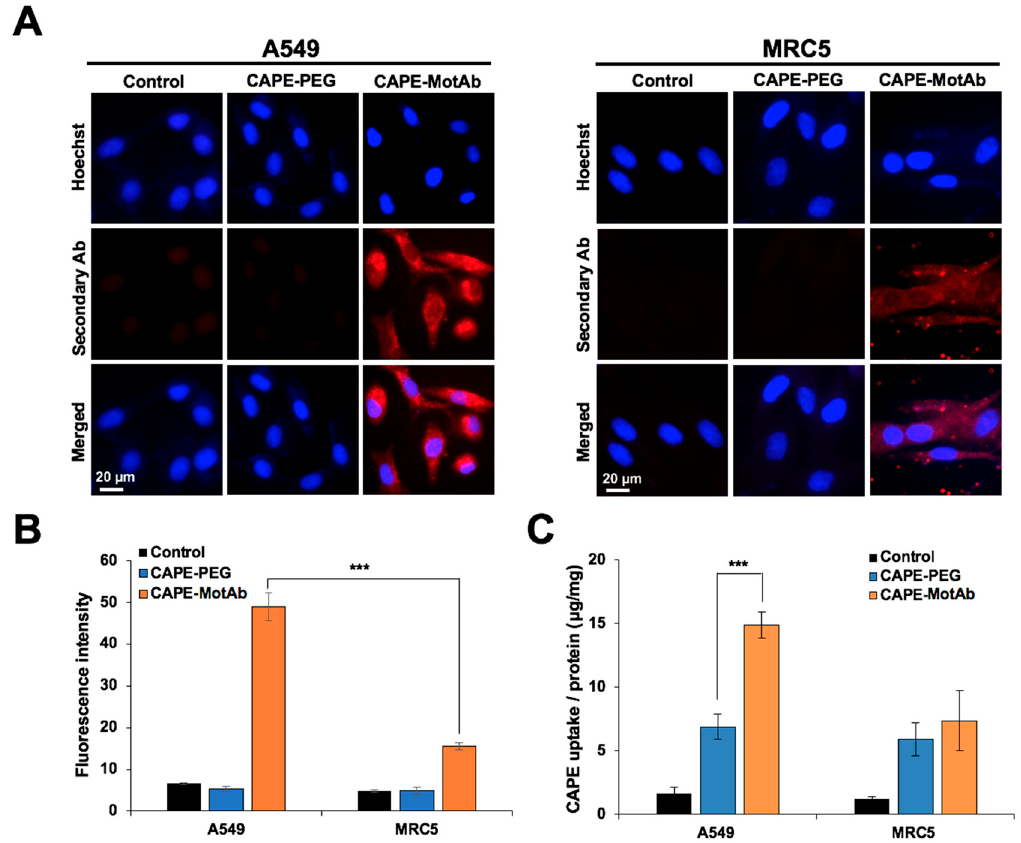
Figure 4. Selective cellular uptake of CAPE-MotAb in cancer cells by targeting mortalin. ( A ) Fluorescence microscopy images of A549 and MRC5 cells treated with CAPE-PEG and CAPE-MotAb followed by staining with Alexa Fluor TM 594-tagged secondary antibody. The nuclei were stained with Hoechst. Higher cellular uptake efficiency of CAPE-MotAb was observed in A549 cells. ( B ) Quantitation of mortalin expression from fluorescence images (mean ± SD, n = 3), *** p < 0.001 (Student’s t -test). ( C ) Quantitative analysis of cellular uptake of CAPE-PEG and CAPE-MotAb in A549 and MRC5 cells (mean ± SD, n = 3), *** p < 0.001 (Student’s t -test). CAPE-MotAb treated A549 cells exhibited higher CAPE accumulation as compared to MRC5 cells treated with the same nanoparticles. A549 and MRC5 cells for all above experiments were treated with an equivalent dose of CAPE (20 µ g / mL) for 12 h.